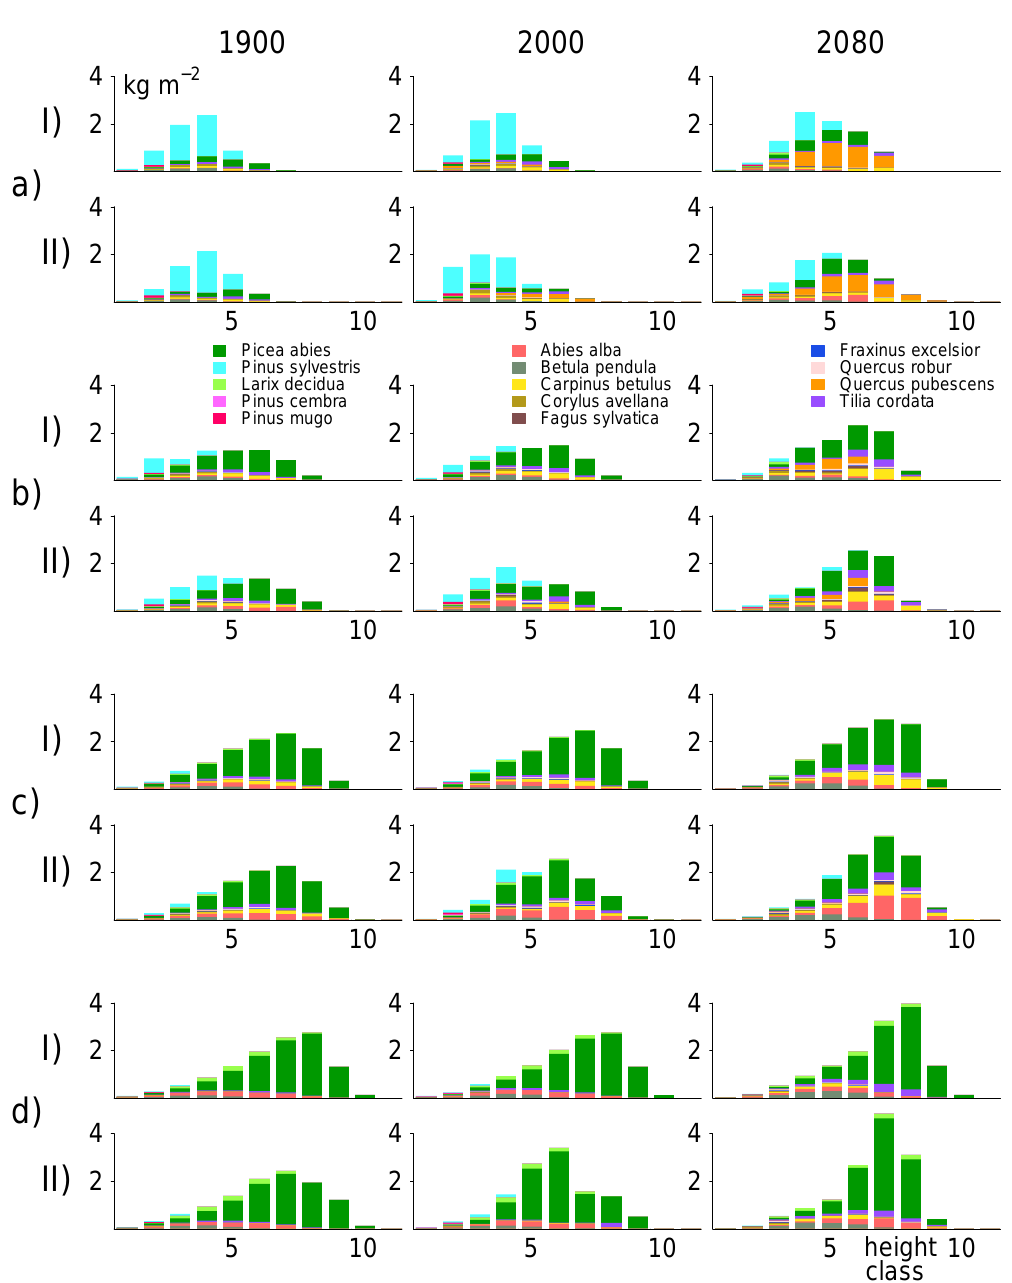
Fig. D5. Simulation results for stands (a) – (d) for the simulation years 1900, 2000 and 2080. Carbon mass per tree species is plotted against tree height classes for (I) LPJ-GUESS using 400 replicate patches, and (II) using the new GAPPARD method against LPJ-GUESS. Height class 1: trees 2–6m height, height class 2: 6–10m, and so